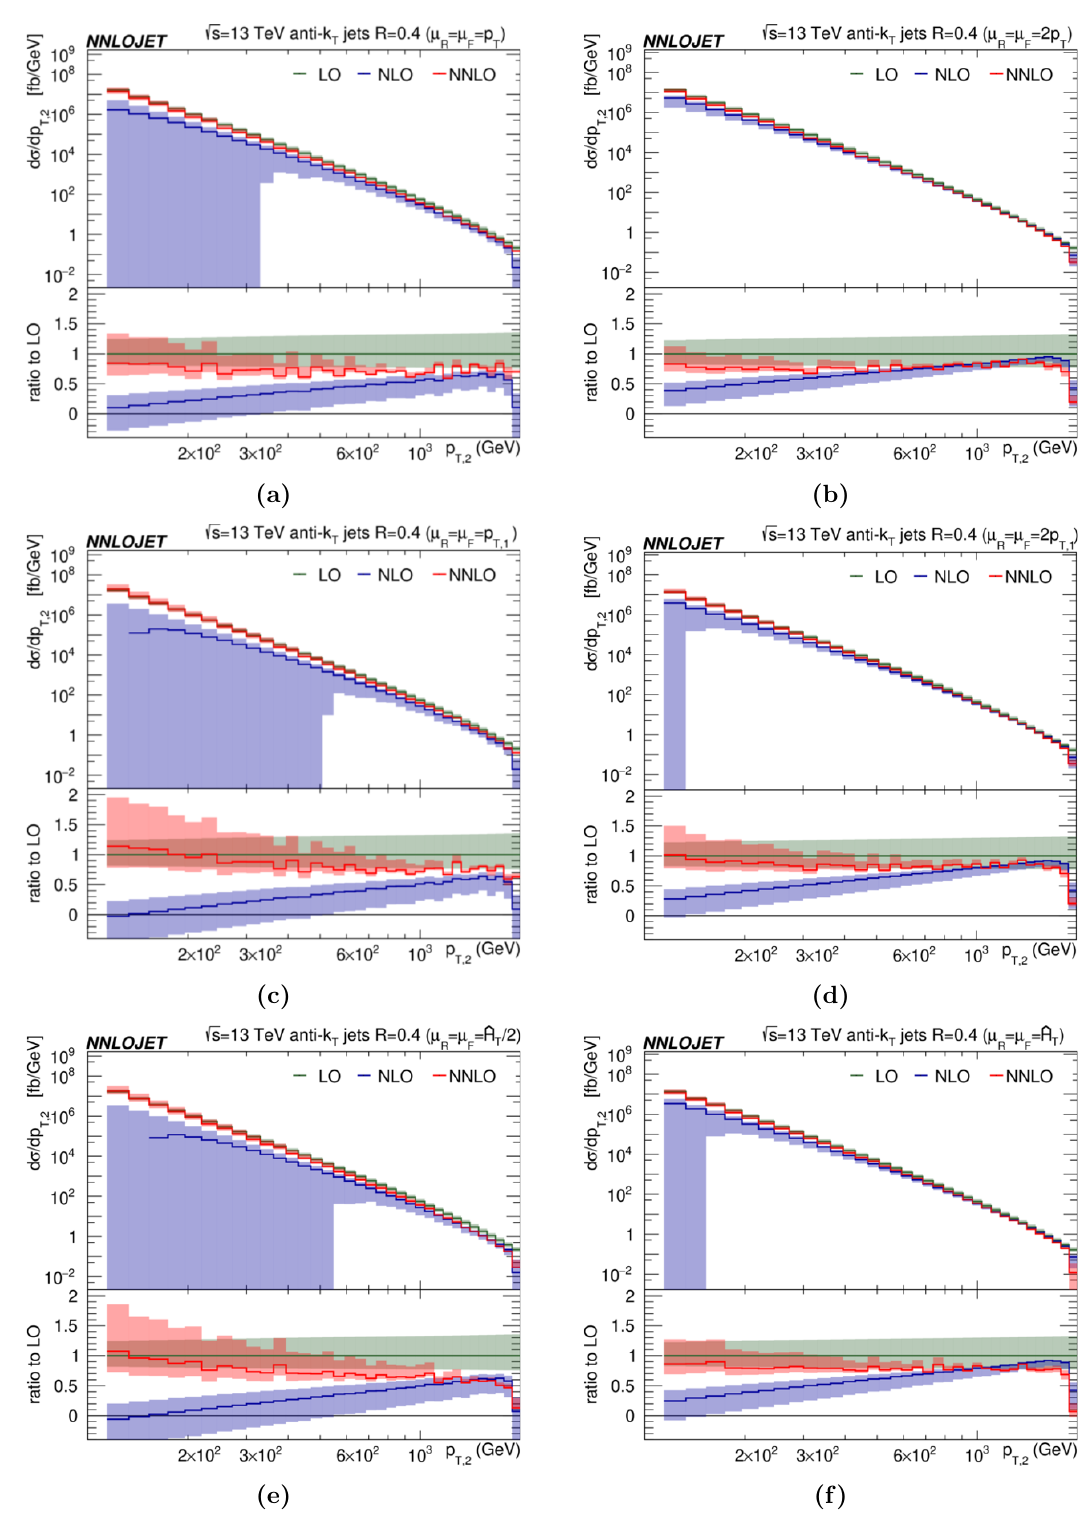
Figure 16 . The transverse-momentum distribution of the subleading jet with R = 0 : 4 for (a) (cid:22) = p T , (b) (cid:22) = 2 p T , (c) (cid:22) = p T ; 1 , (d) (cid:22) = 2 p T ; 1 , (e) (cid:22) = ^ H T = 2, (f) (cid:22) = ^ H T